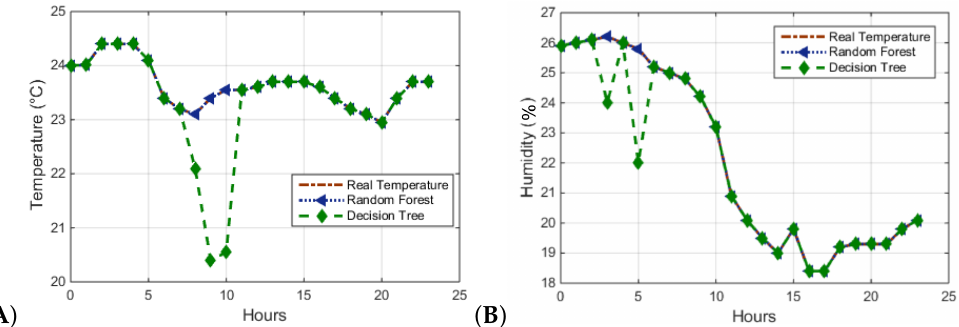
Figure 5. Comparison between predicted and real value of indoor temperature and humidity, during a day (24